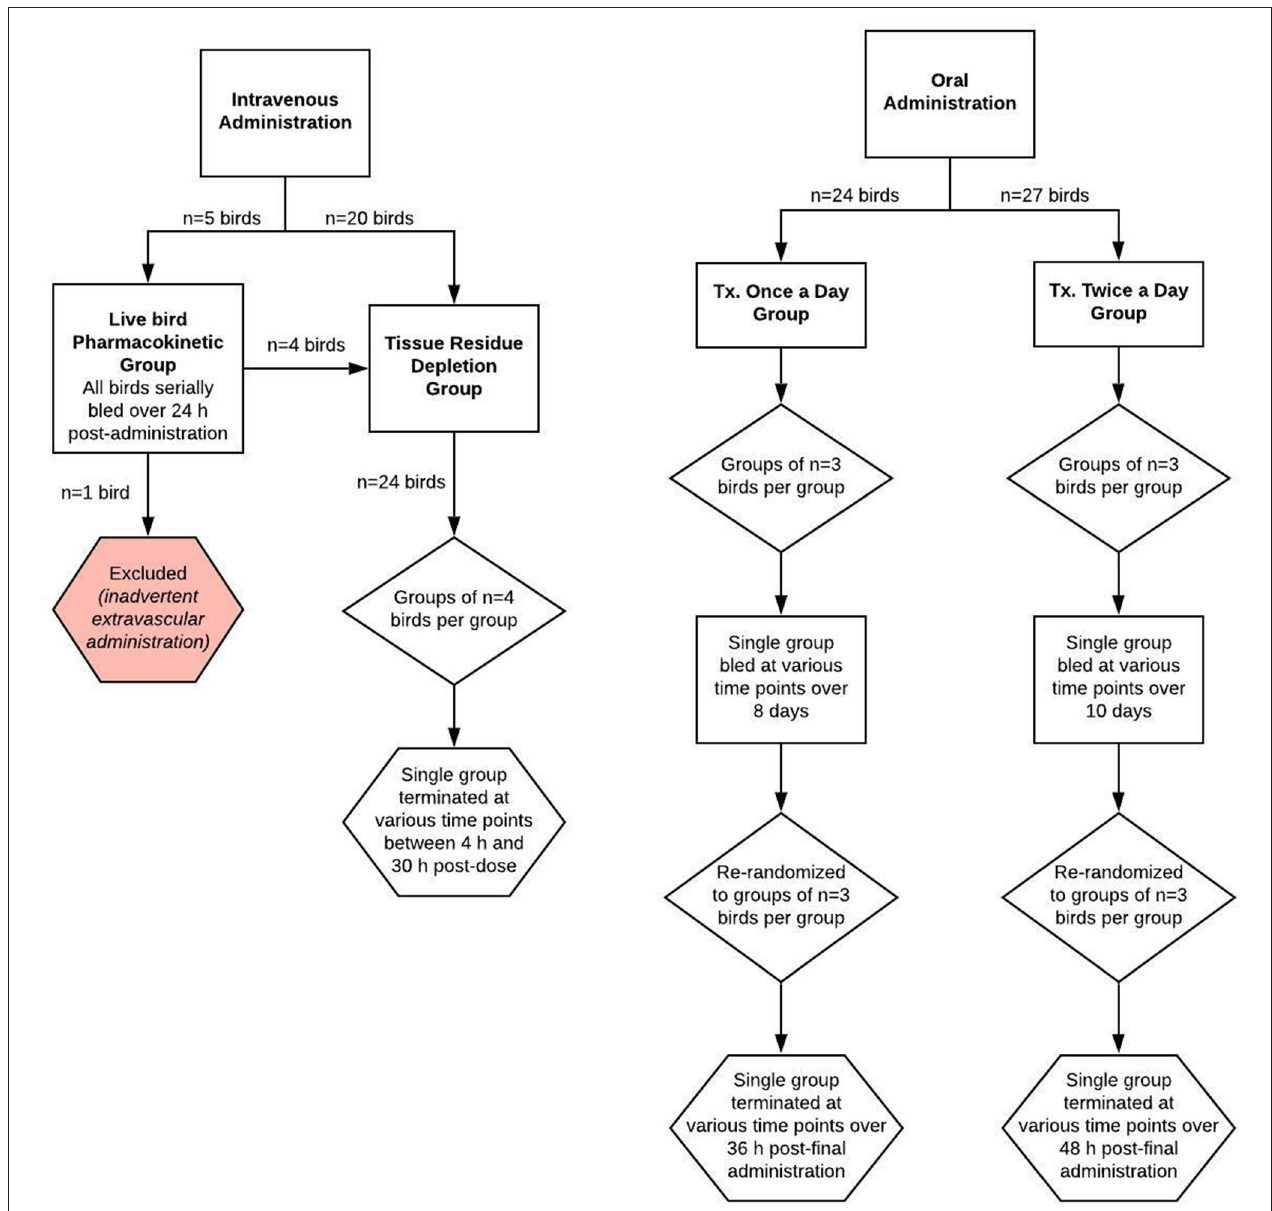
FIGURE 1 | Schematic of the study design for evaluating meloxicam depletion in plasma and tissue samples from adult female laying chickens following once or twice daily oral or intravenous administration of meloxicam at a dosage of 1 mg/kg body weight.